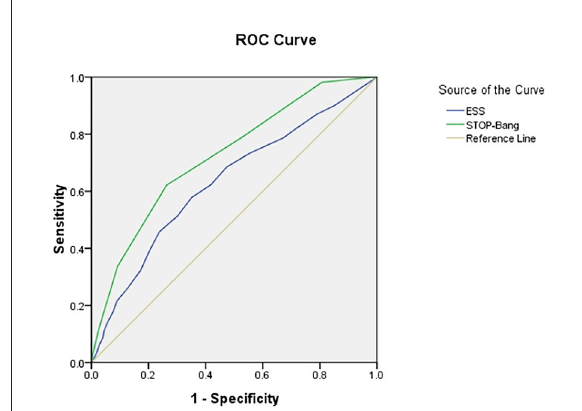
FIGURE2 ROC curve of the ESS and STOP-Bang at AHI cutoff of ≥ 5 events/h (At an AHI cutoff of ≥ 5 events/h, the diagnostic performance of the STOP-Bang is better than the ESS. AHI, apnea-hypopnea index; ESS, Epworth Sleepiness Scale; STOP-Bang, STOP-Bang questionnaire; ROC, receiver operating characteristic).